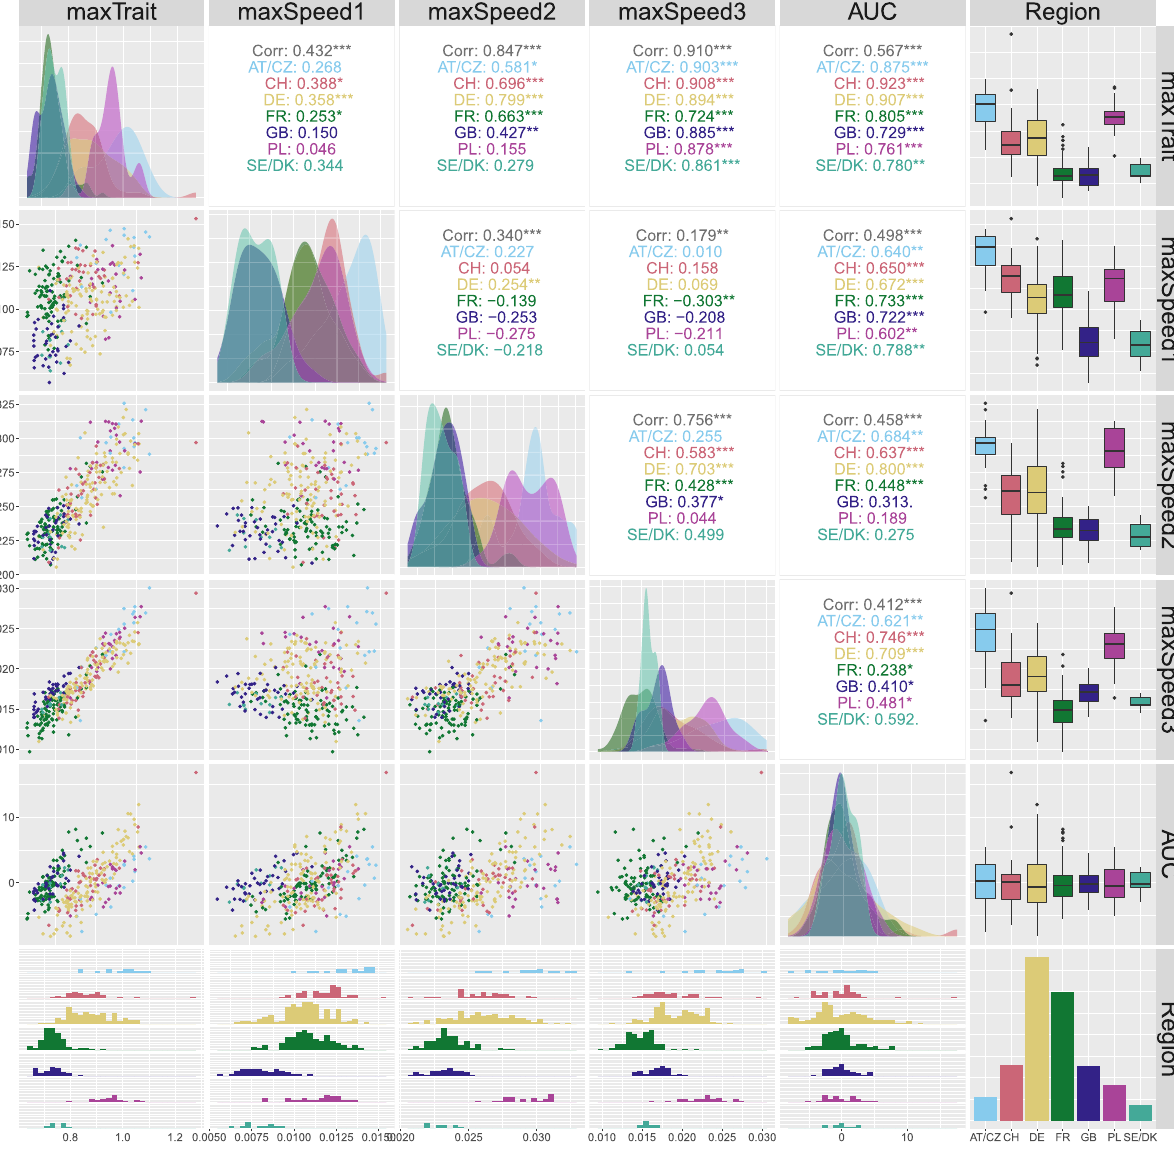
for the complete time interval where the genotypes were measured. Nothing, however, precludes to focus atten- tion on a restricted time interval of interest. The bivariate scatterplots of the extracted genotype-specific attributes show that the genotypes cluster accord- ing to their region of origin (Fig. 8, lower off diagonal, one color per region). Some atypical genotypes can also be identified, for example an old, tall (> 1.2 m) Swiss variety. In the upper off diagonal, we report the Pearson’s correlation coefficient (marginal and by region). The strongest marginal correlations are between maxSpeed3 and maxTrait, and maxSpeed2 and maxTrait; maxSpeed3 and maxSpeed2 also present a high correlation. It is noteworthy that the marginal correlation between maxTrait and AUC is lower than the conditional correlation by region. Univariate analysis of each attribute using boxplots also shows regional clustering, and that clusters might change along time (e.g., compare clusters in maxSpeed1, maxSpeed2 and maxSpeed3).